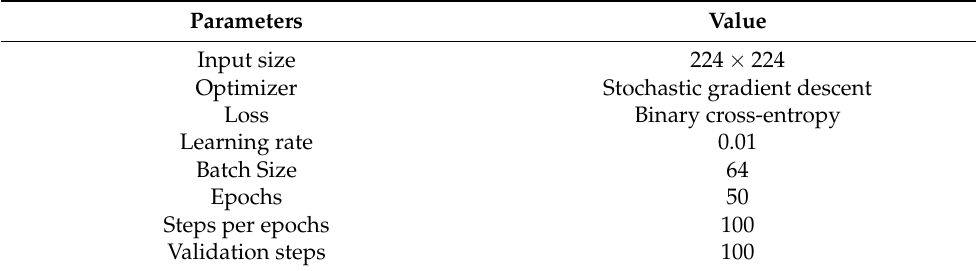
Table 2. Simulation